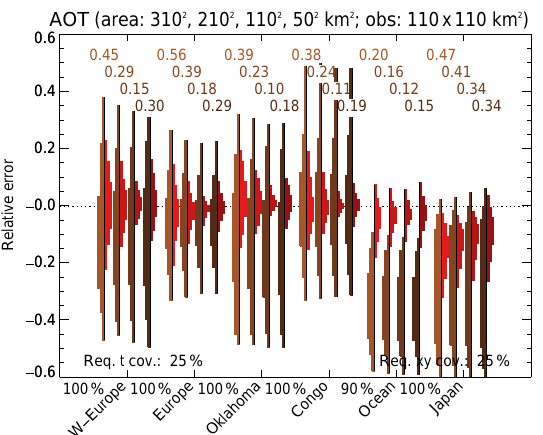
Figure 15. Monthly representation errors for an imager on a polar- orbiting satellite at different area sizes but with the observations aggregated over 110 × 110km 2 : no collocation (different shades of brown) and model data collocated to the hour (different shades of red). Results for a repeat cycle of 1 day. Further explanation in Sect. 3.2.